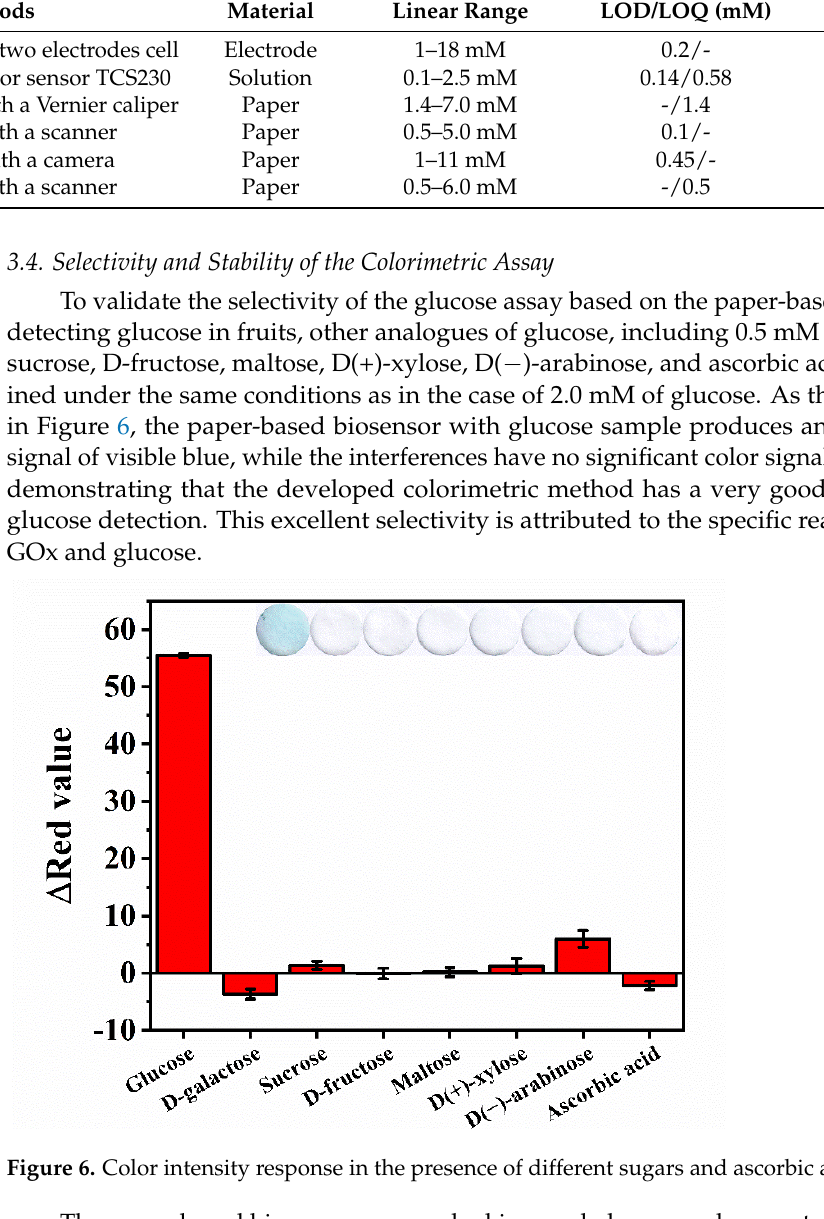
Figure 7. Storage stability of the paper device in a refrigerator at 4 °C.